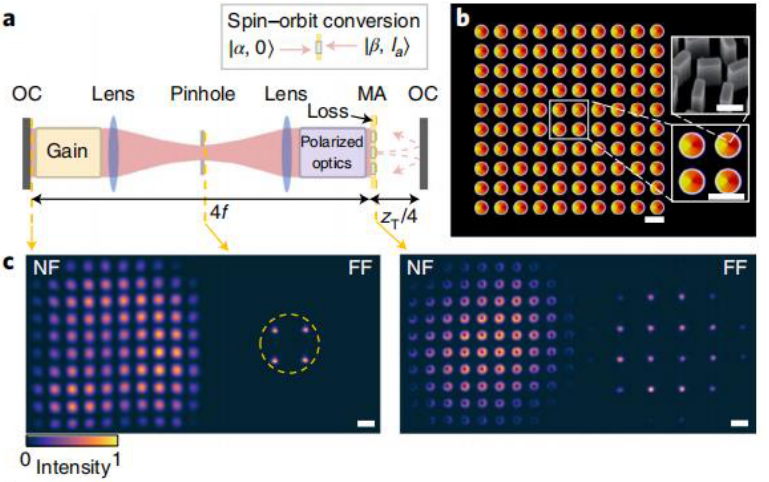
Figure 20. ( a ) Diagrammatic experimental setup of the laser degenerate resonator using a metasurface array; ( b ) Optical image of the metasurface array; ( c ) Experimental intensity profiles of the arrays at near field and far field in the front and rear end of the resonator, respectively (Adapted from an open-access source Ref. [123]).